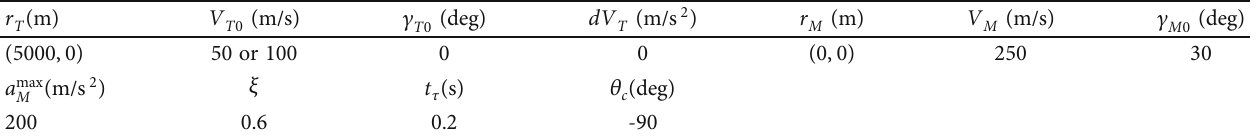
Table 6: Simulation conditions for Case